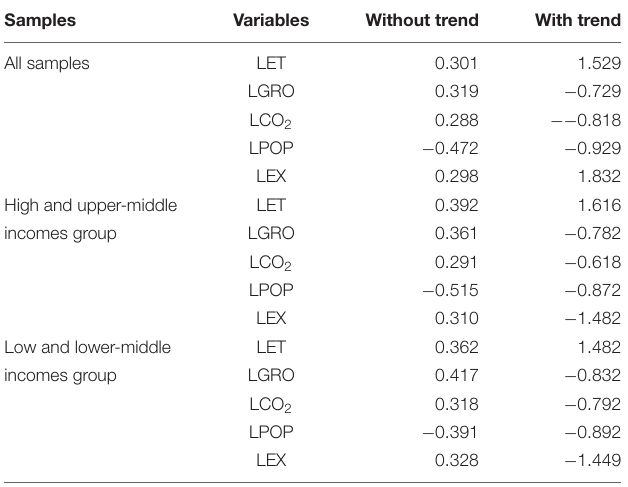
TABLE 5 | Pesaran (2007) panel unit root test results. Samples